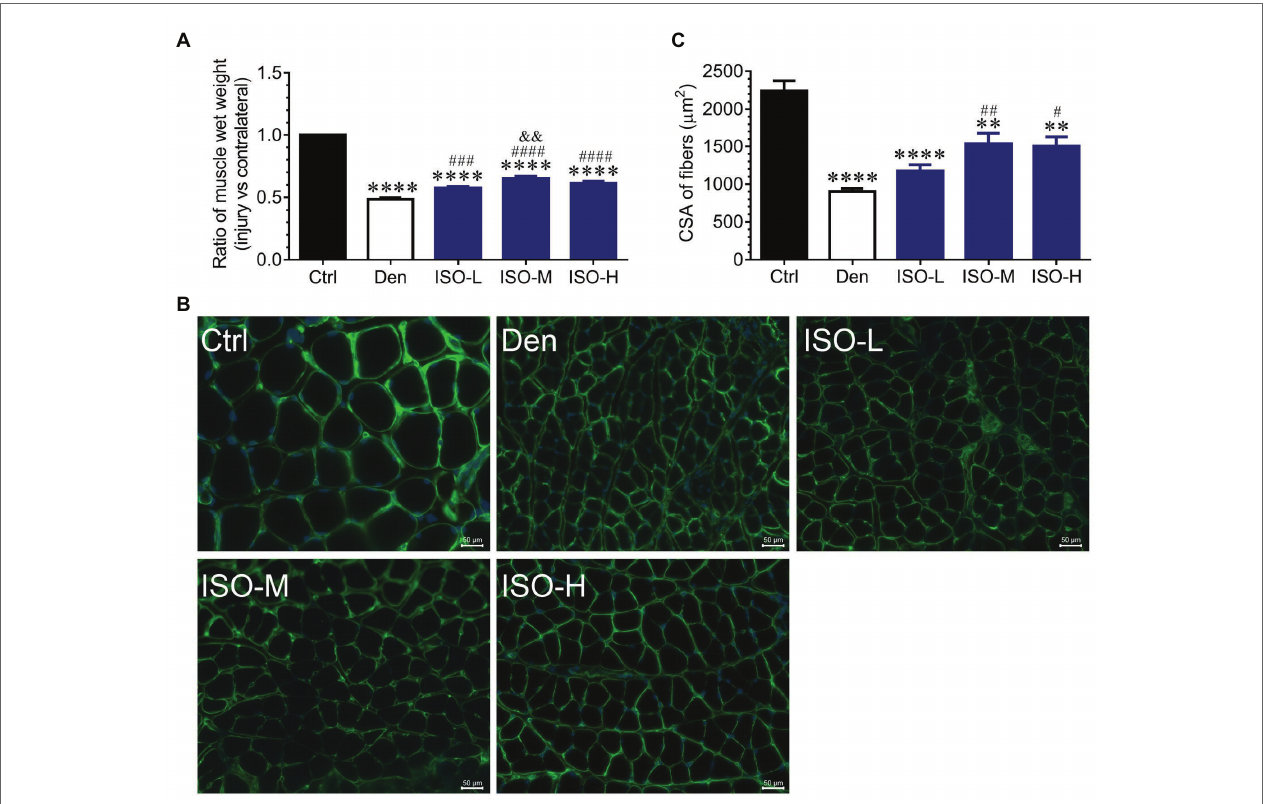
FIGURE 1 | Isoquercitrin reduces soleus muscle mass loss caused by denervation ( n = 6). (A) The ratio of muscles wet weight in each group. (B) Representative images of laminin-stained muscles cross-sections in each group. Green indicates laminin staining. Scale bar: 50 μ m. (C) The histogram shown the cross-sectional area (CSA) of muscles in each group. Ctrl, control group; Den, denervation group; ISO-L, denervated target muscle plus low-dose isoquercitrin (10 mg/kg/d); ISO-M, denervated target muscle plus middle-dose isoquercitrin (20 mg/kg/d); ISO-H, denervated target muscle plus high-dose isoquercitrin (40 mg/kg/d). ** p < 0.01 and **** p < 0.0001 vs. Ctrl; # p < 0.05, ## p < 0.01, ### p < 0.001, and #### p < 0.0001 vs. Den; && p < 0.01 vs.